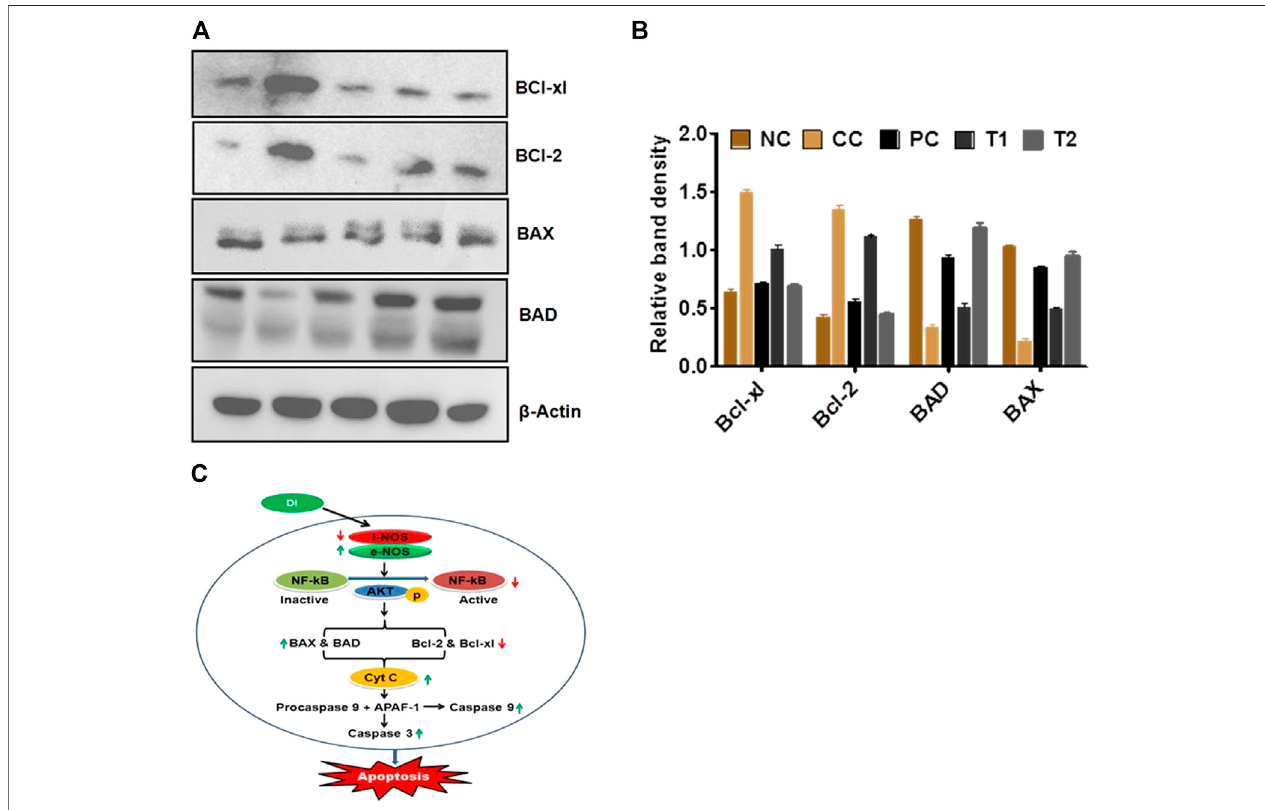
FIGURE 4 | (A,B) Protein expression levels of BAD, BAX, Bel-xl, Bcl-2, and β -actin in liver tissue after treatment with DI (determined by quantitative Western blot analysis). (C) Plausible mechanism of anticancer activity of DL. Data are represented as mean SD ( n (cid:1) 8). Statistically signi fi cant differences were observed between carcinogen control and test groups (one-way ANOVA followed by the Bonferroni multiple comparison test (*** p < 0.001, ** p < 0.01, * p < 0.05)). The studied groups are NC, Normal Control; CC, Carcinogen Control; PC, Positive Control; TI, DI (100 mg/kg) and T2, DI (200